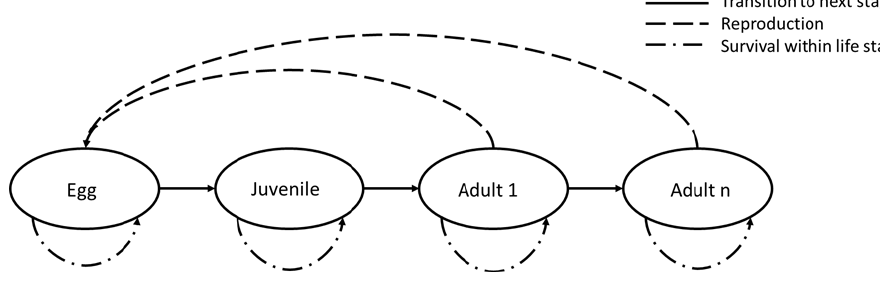
Figure 1. Life history representation for the signal crayfish ( Pacifastacus leniusculus ). The general life cycle includes eggs (embryos) which remain at that stage until they hatch into juveniles. Juveniles remain in the juvenile stage until they mature into the adult life stage. Only adults can reproduce, and reproductive output is size/age dependent. Adult life stage can be separated to multiple stages (n) due to the size/age dependent reproductive output as well as data availability for survival rates of different life stages.